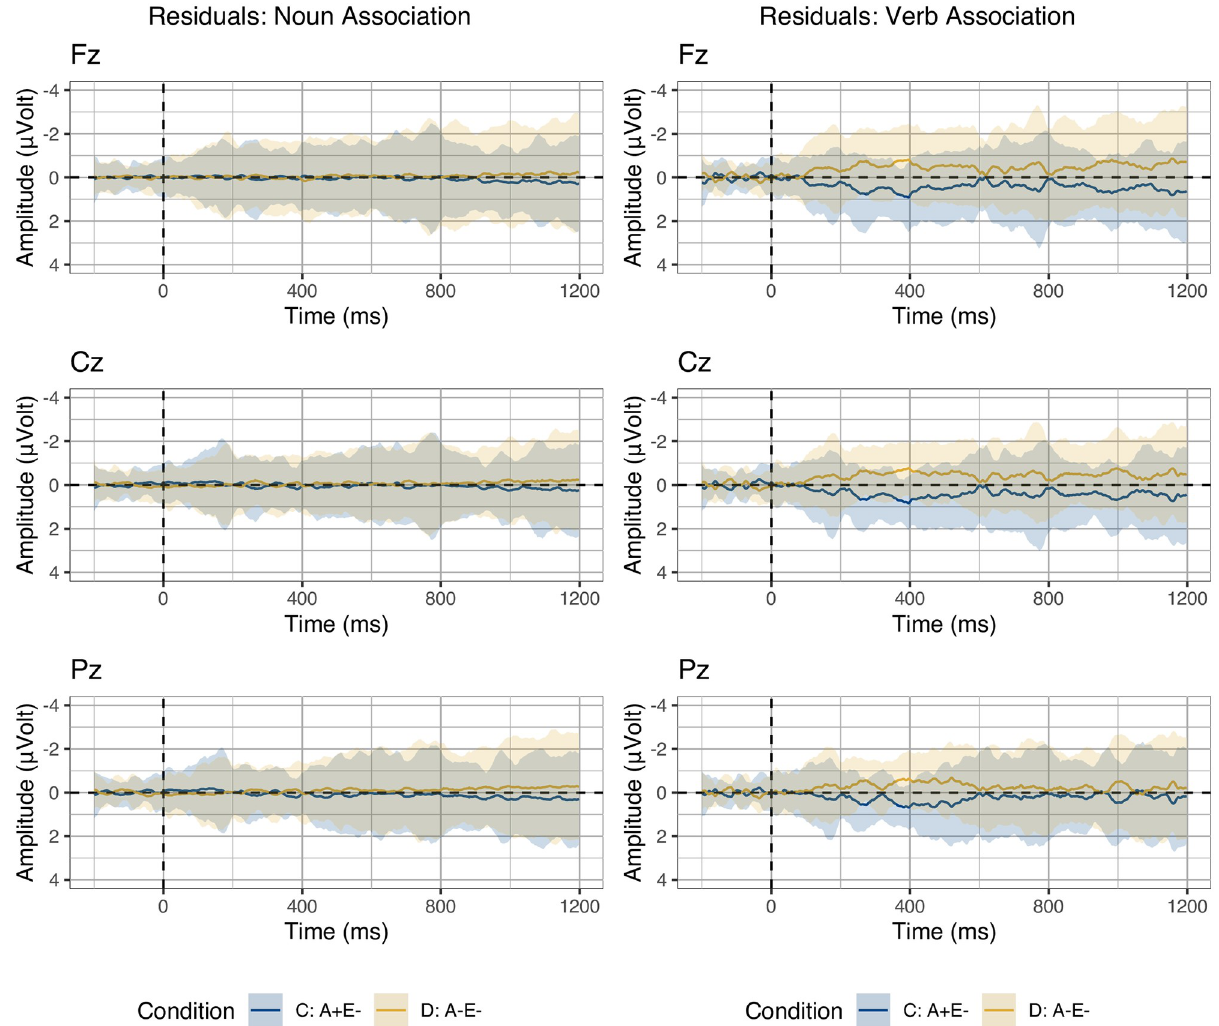
Fig 4. Residual error: Association. Residual error between observed voltages and estimated voltages in Conditions C and D using noun-target (left) or verb-target association (right) as predictor. Larger deviations from zero indicate larger model error. Ribbons indicate standard error computed from the per-subject per-condition